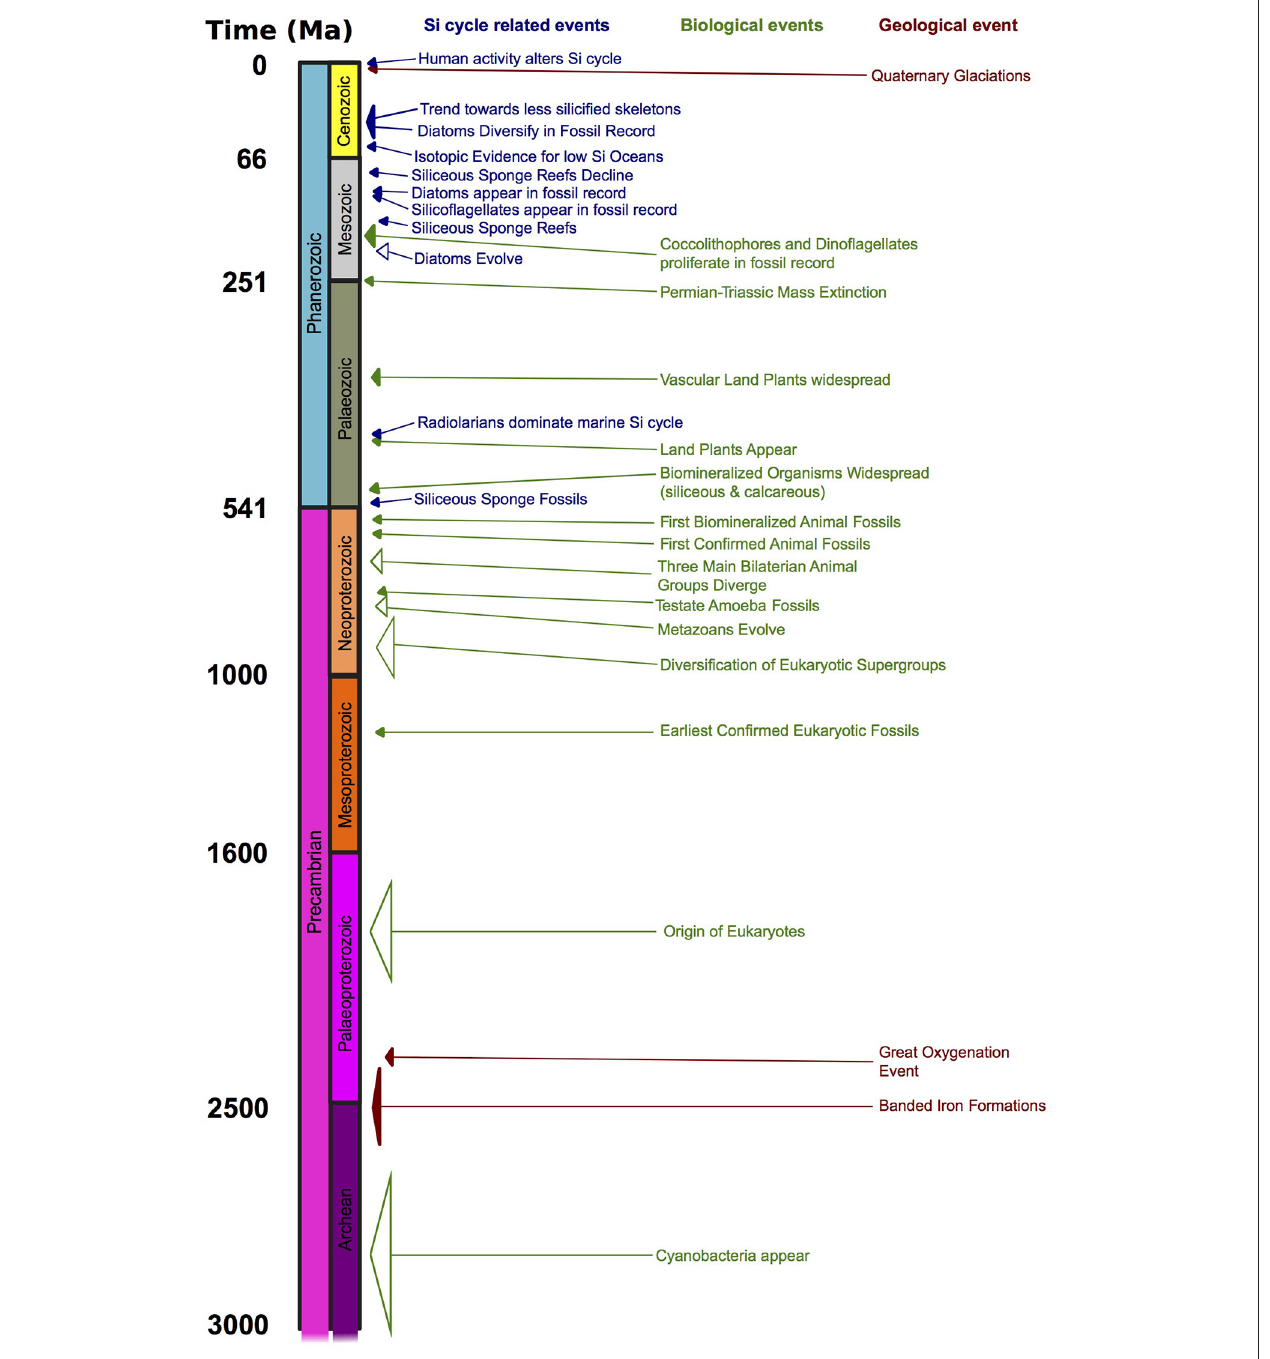
FIGURE 6 | Significant biological and geological events throughout geologic time that affect the global oceanic Si cycle. Events are color coded for the different types of events (blue for Si-related, green for biological, dark red for geological). The size of the open arrows denote uncertainty in the determination of the molecular clock